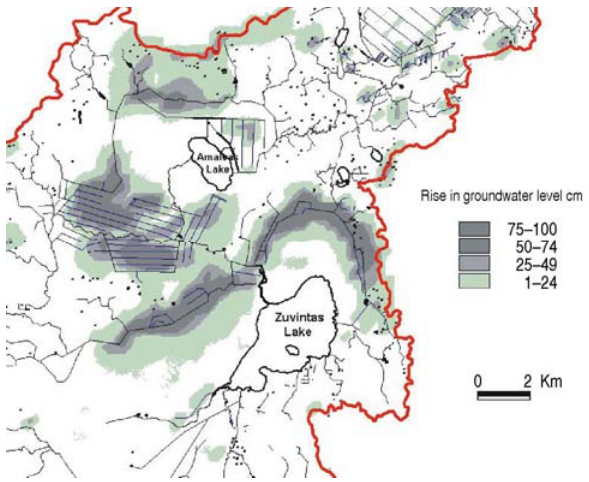
Fig. 8. Average annual rise of groundwater level around wetlands after blocking of drainage